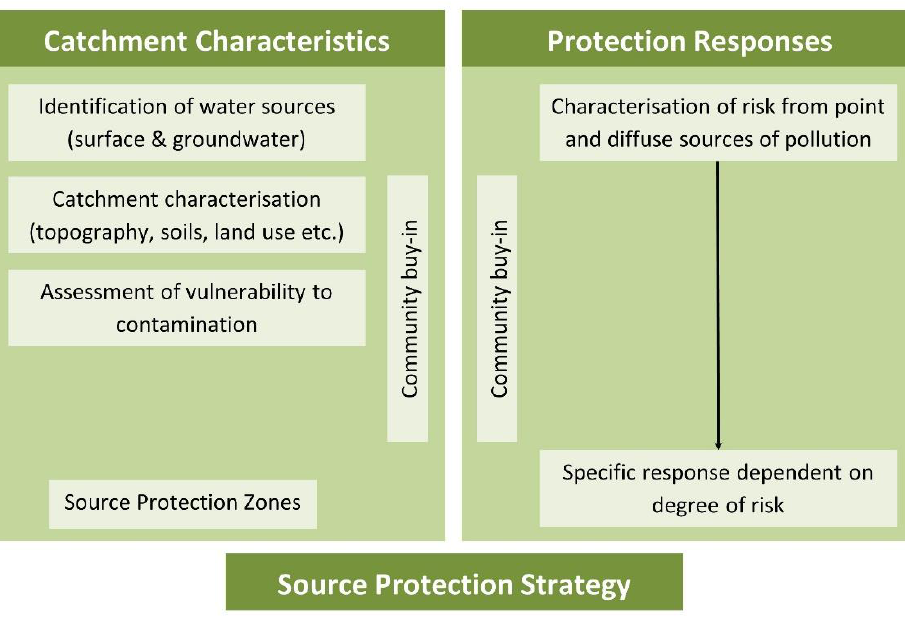
(Figure 4: R 2 = 0.6659). The majority of Group Water Schemes abstracting from surface waters (91%) serve a population of less than 3000 people, with 94% of Group Water Schemes supplying less than 1500 m 3 . Group Water Schemes supply both domestic and non-domestic (predominantly agricultural, but also some commercial) consumers, and consequently, it is not possible to estimate per capita consumption using the regression line presented in Figure